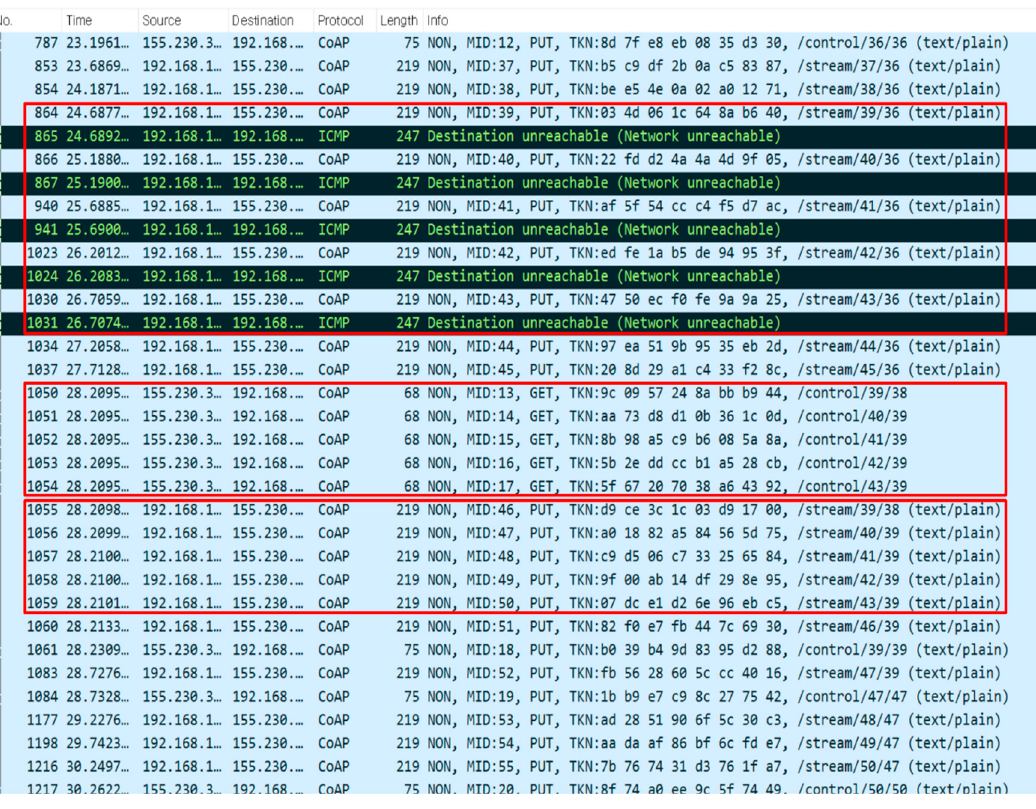
Figure 12. Packets of error handling for CoAP-SC.